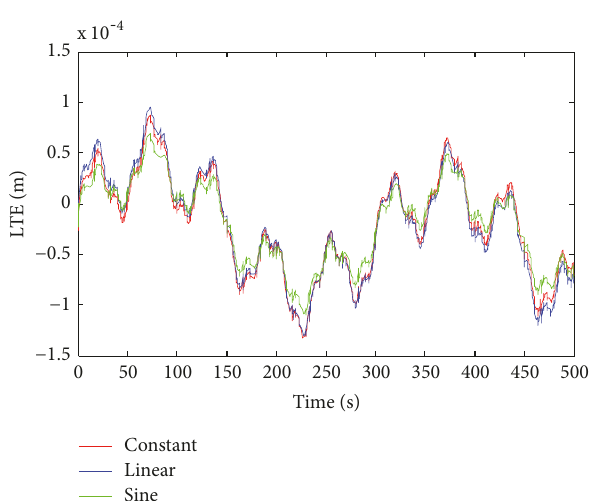
Figure 10: LTE curves under variable load